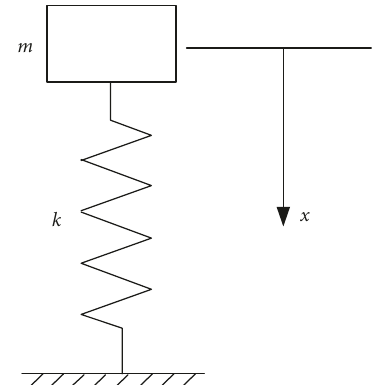
Figure 1: A single-DOF vibration model of the